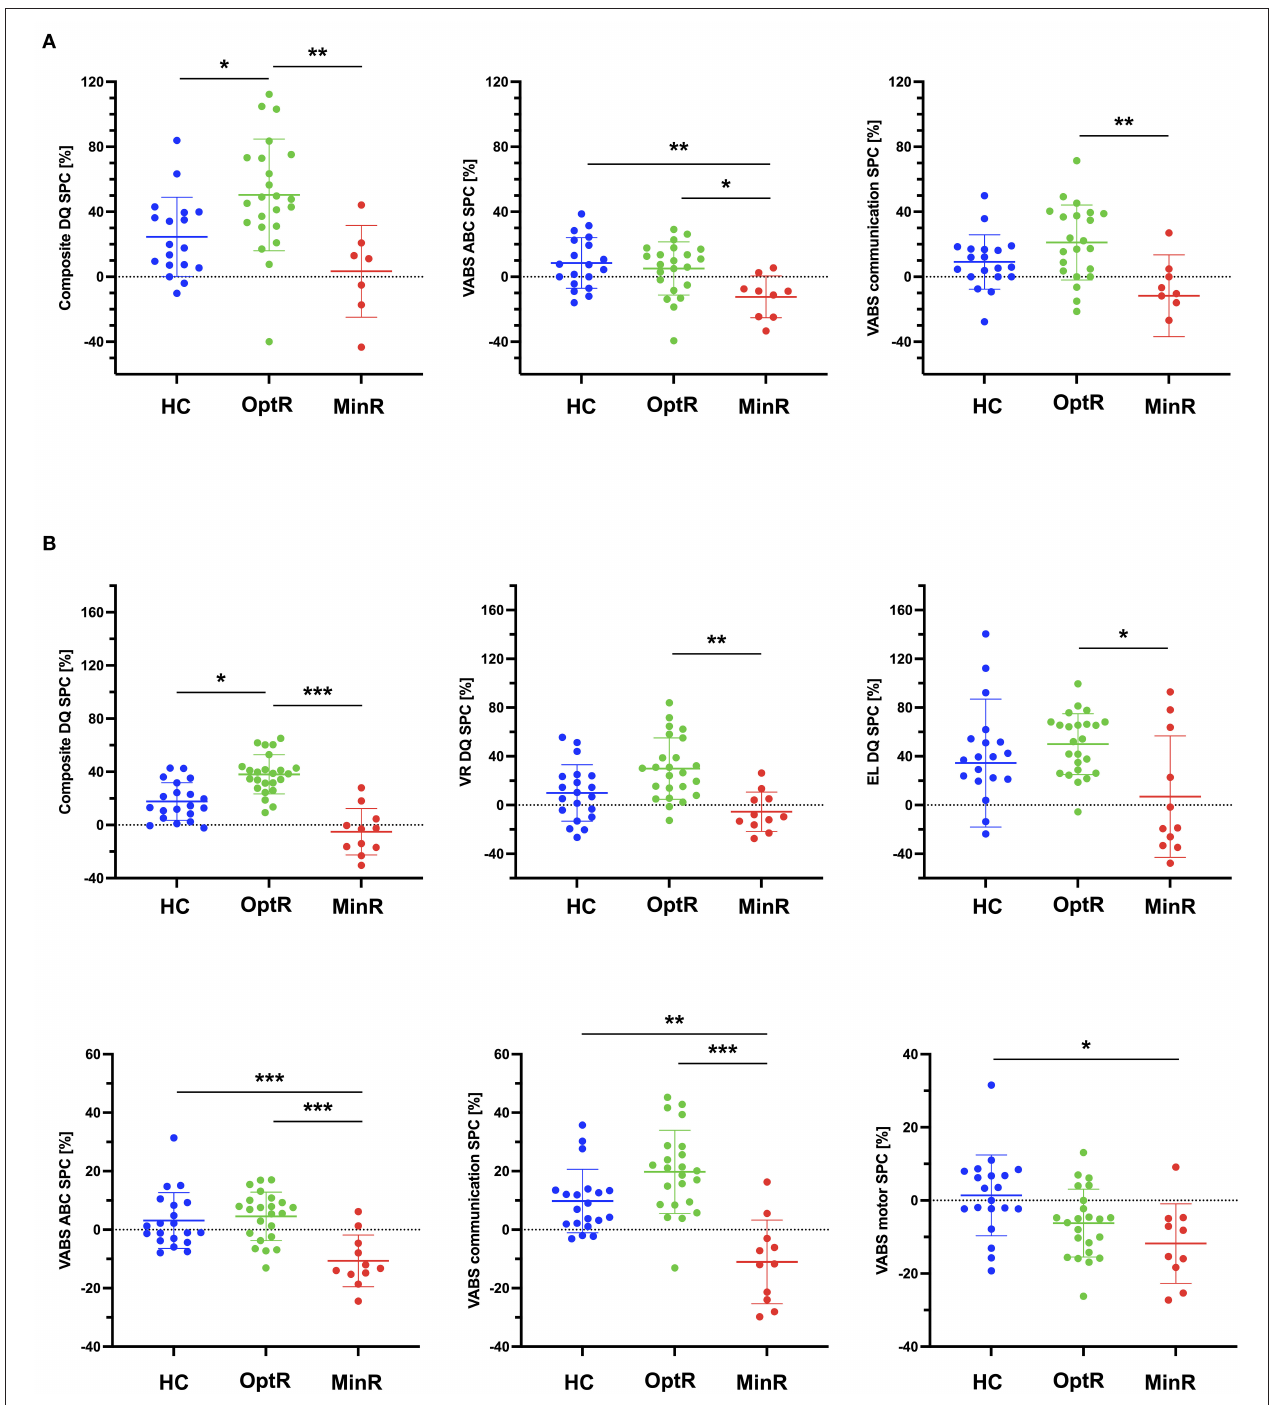
FIGURE 3 | (A) Statistically significant differences between subgroups in the rates of change of behavioral measures (DQ and VABS-II) within the first 6 months of intervention. (B) Statistically significant differences between subgroups in the rates of change of behavioral measures (DQ and VABS-II) within the first 12 months of intervention. * p < 0.05, ** p < 0.01, *** p < 0.001. ABC, Adaptive behavior composite; DLS, Daily living skills; DQ, Developmental quotient; EL, Expressive language; FM, Fine motor; HC, Higher cognitive; MinR, Minimal responders; OptR, Optimal responders; RL, Receptive language; SPC, Symmetrized percent change; VABS-II, Vineland adaptive behavior scale; VR, Visual